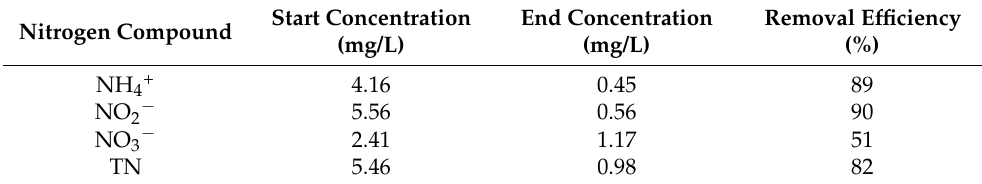
Table 3. Nitrogen removal efficiency in a preliminary experiment (matrix: Elbe-/tap water (1:10); v F = 0.032 m/h; c 0 (NH 4+ ) = 4.16 mg/L; c 0 (NO 2 − ) = 5.56 mg/L; c 0 (NO 3 − ) = 2.41